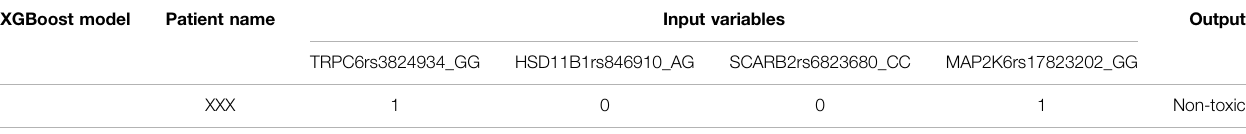
TABLE 3 | The result of nephrotoxicity after treating with TAC of clinical patient predicted by XGBoost model. XGBoost